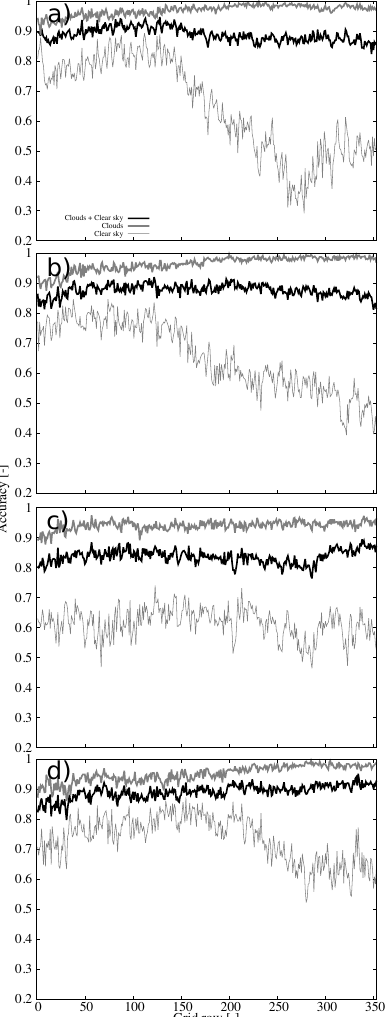
Figure 8. Accuracy as a function of the grid row for daytime during ( a ) Winter, ( b ) Spring, ( c ) Summer, and ( d ) Autumn. The accuracy for all sky conditions, cloudy, and clear sky are shown (see legend).